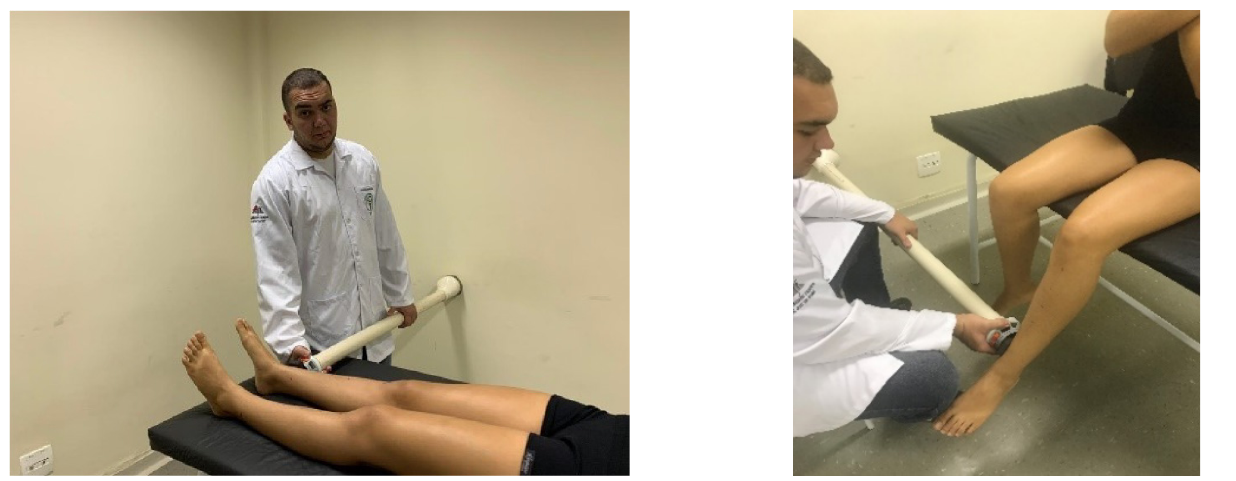
Figure 3 - Hip abductors (kgf/kg). Figure 4 - External rotators (kgf/kg).